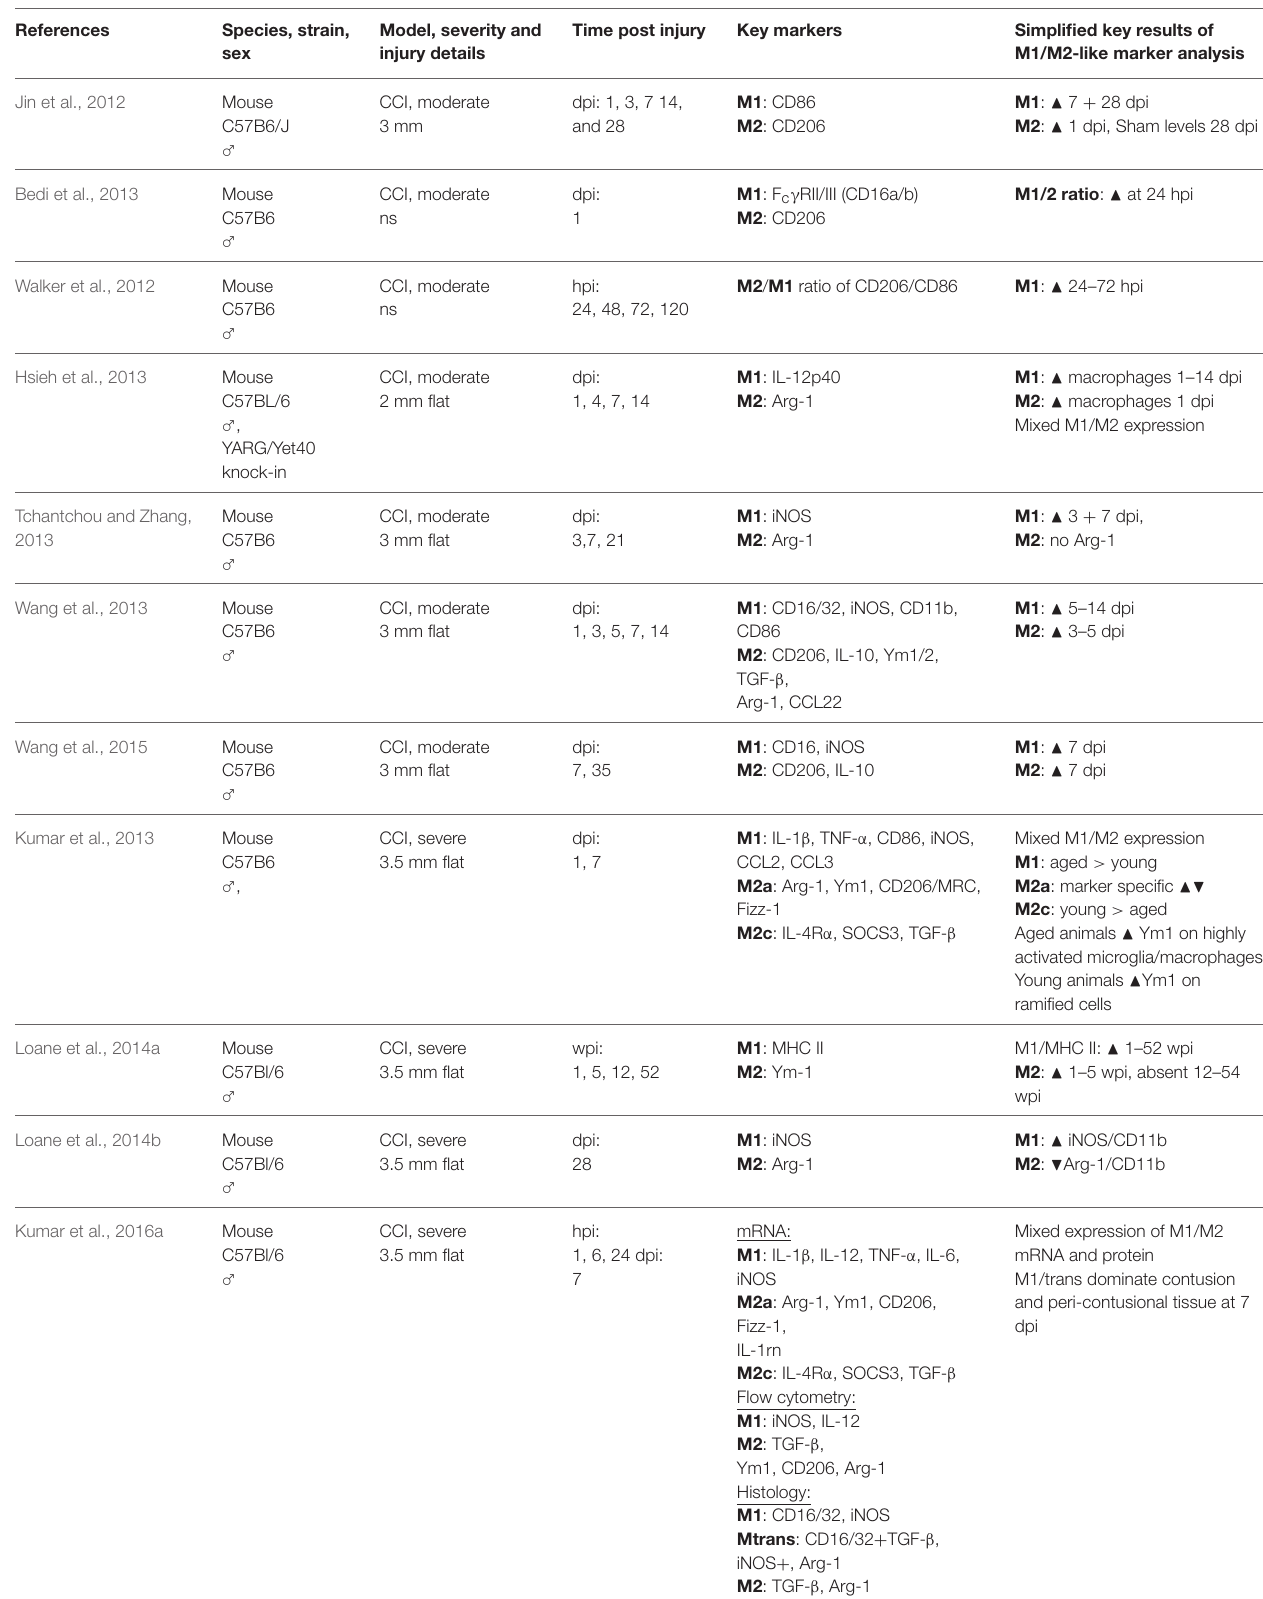
TABLE 1 | Microglia/macrophage polarization in experimental models of Traumatic Brain Injury.